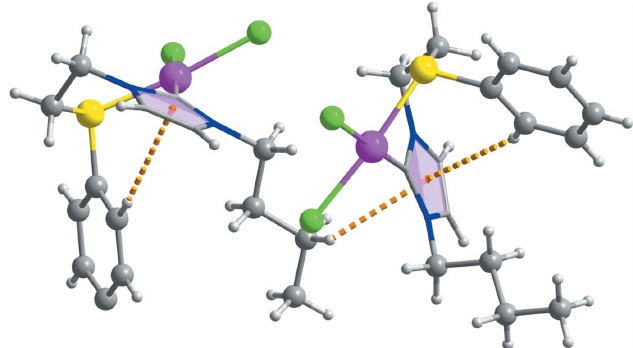
Figure 3 A view of the crystal packing of the title complex. Dashed lines denote the intermolecular C—H (cid:2)(cid:2)(cid:2) Cl hydrogen bonds.